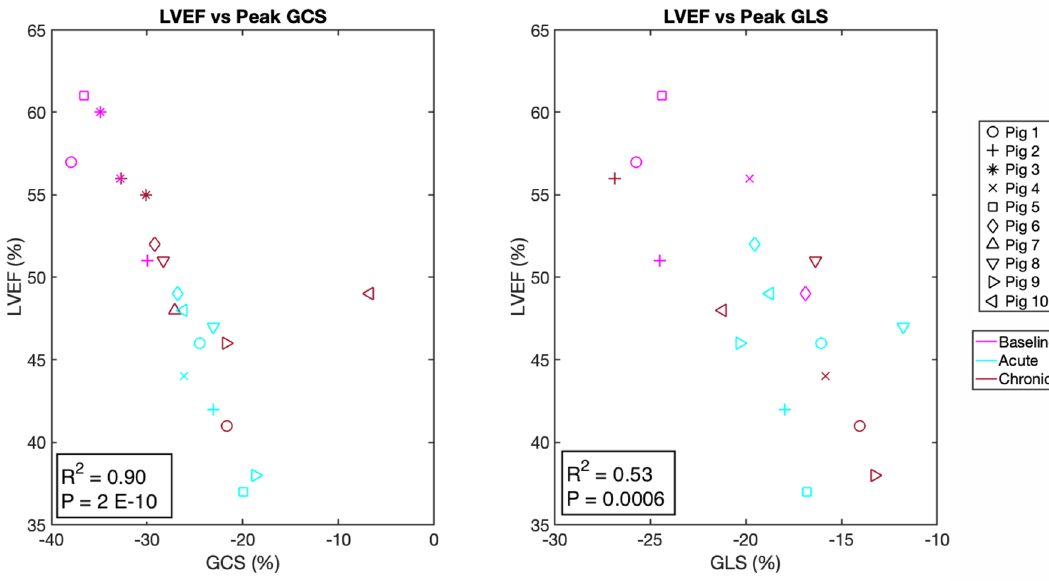
Figure 4. Correlation between endocardial GCS and GLS with LVEF. Scatterplot between endocardial GCS and LVEF ( A ) and between endocardial GLS and LVEF ( B ). Each individual porcine specimen is denoted by a different marker and three different line colours are used to indicate the experimental time point of baseline, acute, and compared to baseline (− 37.5%), whereas the change at the acute time point did not reach statistical significance (− 17.7%, p = 0.004) (Table 1). GCS showed a significant change at the acute time-point (− 23.8%, p = 0.002) vs. baseline (− 34.9%), whereas the change observed at the chronic time-point did not reach statistical significance (− 27.7%, p = 0.006). The endocardial equatorial CS (ECS) and basal CS (BCS) strains showed no statistical changes across the two time-points, with all p > 0.01 (Table S4, Online Supplement). No significant changes were seen in epicardial CS, with all p > 0.03 (Table S4). Endocardial and epicardial strain rates did not differ at the acute or chronic time-points vs. baseline ( p > 0.008; Fig. 3E–G and Table S4). No significant correlations were observed between scar weight and circumferential strains. The intra-observer variability for LVEF and LVEDV were 3% and 2% respectively, and the inter-observer variation were 8% and 7% respectively. LV global function and associations with strain. LVEF and left ventricular end systolic volume index (LVESVi) were measured by established CMRI methods (Table S1, Online Supplement) with relevant strain contours derived by hand (Table 1). LVEF dropped significantly only at the acute time-point vs. baseline ( p = 0.0023) (Table 1 and Fig. 3E–G). Scatterplots of GCS versus LVEF (R 2 = 0.90, p < 0.0001) and GLS versus LVEF (R 2 = − 0.53, p = 0.0006) indicated strong and moderate correlations respectively (Fig. 4). LV volumes indexed to weight were assessed given the substantial weight gain observed from acute to chronic time-points. This showed that there were no significant changes in LVESVi from acute to chronic time-points (Table 1). No difference was seen in LVEF values between those measured by CMRI and the relevant strain contours derived by hand. Early changes in strain predicted late LVR: ACS: baseline: − 37.5%, chronic: − 19.1%, p = 0.002; GCS: baseline: − 34.9%, acute: − 23.8%, p = 0.002, chronic: − 27.7%, p = 0.006. Correlation analysis of GCS, GLS, ACS with LVEF and LVESVi are shown in Table S6. Myocardial proteomics, LV strains, and validation of D-3PGDH and sFRP1 by western blot- ting. Proteomics data and correlation with LV strains are reported in Fig. 5, Tables S5, S6 and S7 (Online Sup- plement). 5981 proteins were identified: proteins were regarded as differentially expressed if they revealed more than twofold changes in the infarcted area. 39 proteins were at least twice overexpressed in infarcted territories compared to non-infarcted regions (Fig. 5). For the analysis correlating proteomics with strains, proteomics data from 4 hearts was used as strains were not available for the 5 experiments. Significant linear correlations were found between endocardial circumferential strain rate (ECSR) and 21 of the proteins increased in the infarcted territories (Table S6, Online Supplement). The proteins showing the strongest correlation (R 2 ≥ 0.95) with the ECSR were: D-3-phosphoglycerate dehydrogenase (D-3PGDH, R 2 = 0.96, p = 0.01), cysteine and glycine-rich protein-2 (CG-RP, R 2 = 0.95, p = 0.02), and secreted frizzled-related protein 1 (sFRP1, R 2 0.96, p = 0.01). Western blotting for D-3PGDH and sFRP1 confirmed that the level of D-3PGDH and sFRP1 protein in the infarcted myocardium was significantly increased compared to the non-infarcted myocardium (both P < 0.05, Fig. 6). Western blotting for CG-RP showed no difference.